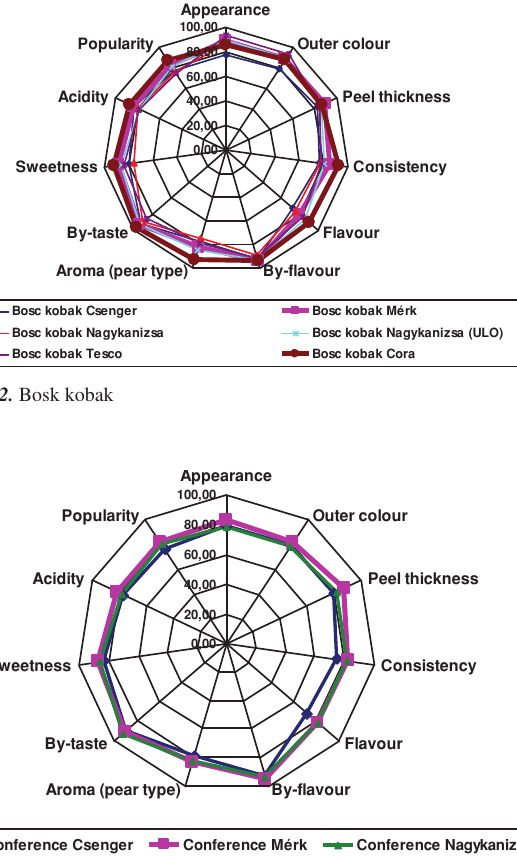
Figure 3. Conference